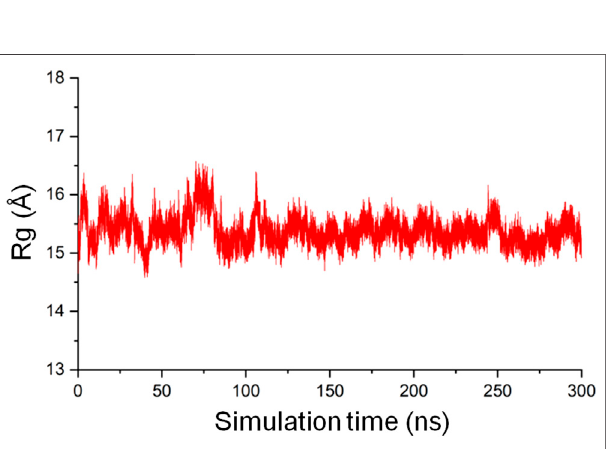
FIGURE 5 | The radius of gyration of the CbtA-model